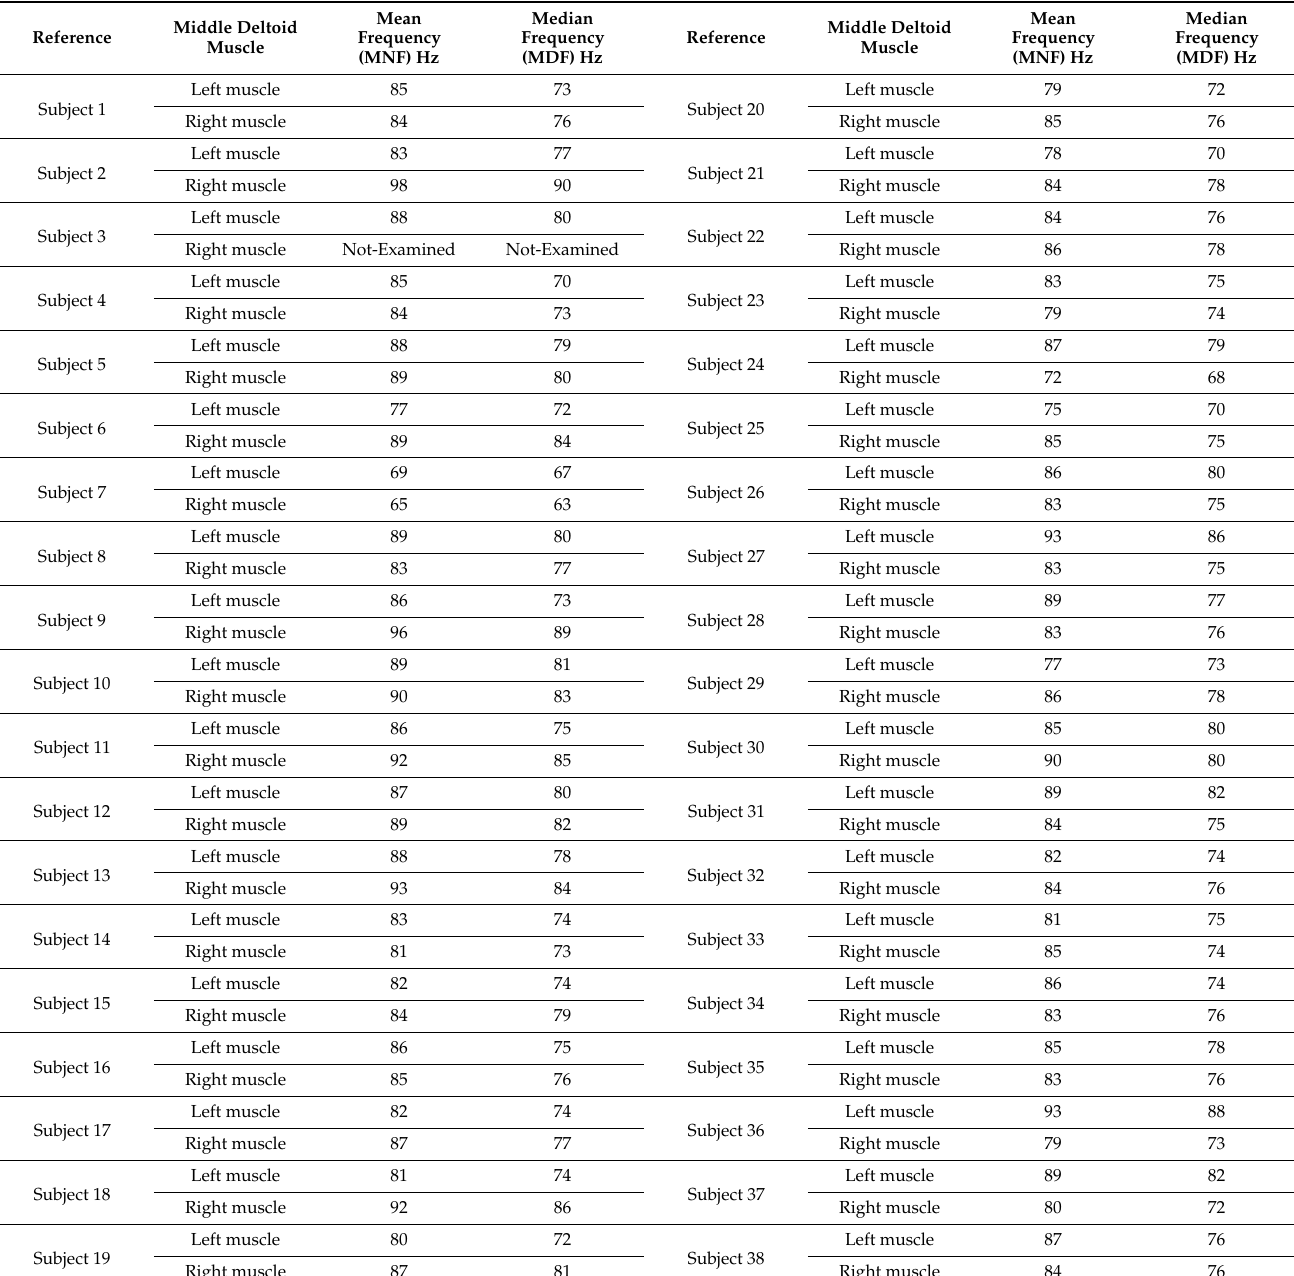
Table 3. MNF and MDF values for deltoid muscle in fatigue